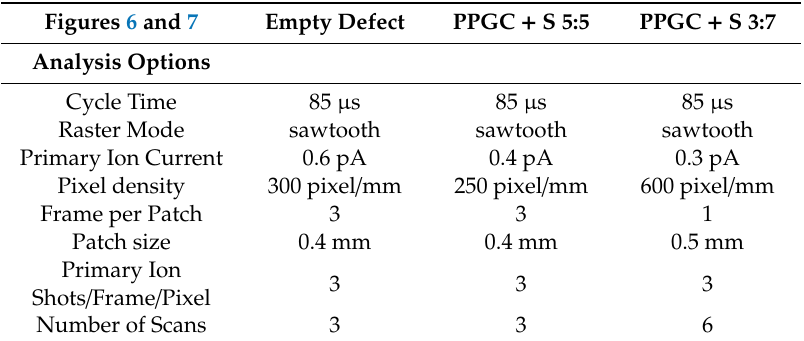
Table 2. Parameters for ToF-SIMS images (Figures 6 and 7) obtained in positive ion mode with M6 Hybrid SIMS (IONTOF GmbH, Münster, Germany).